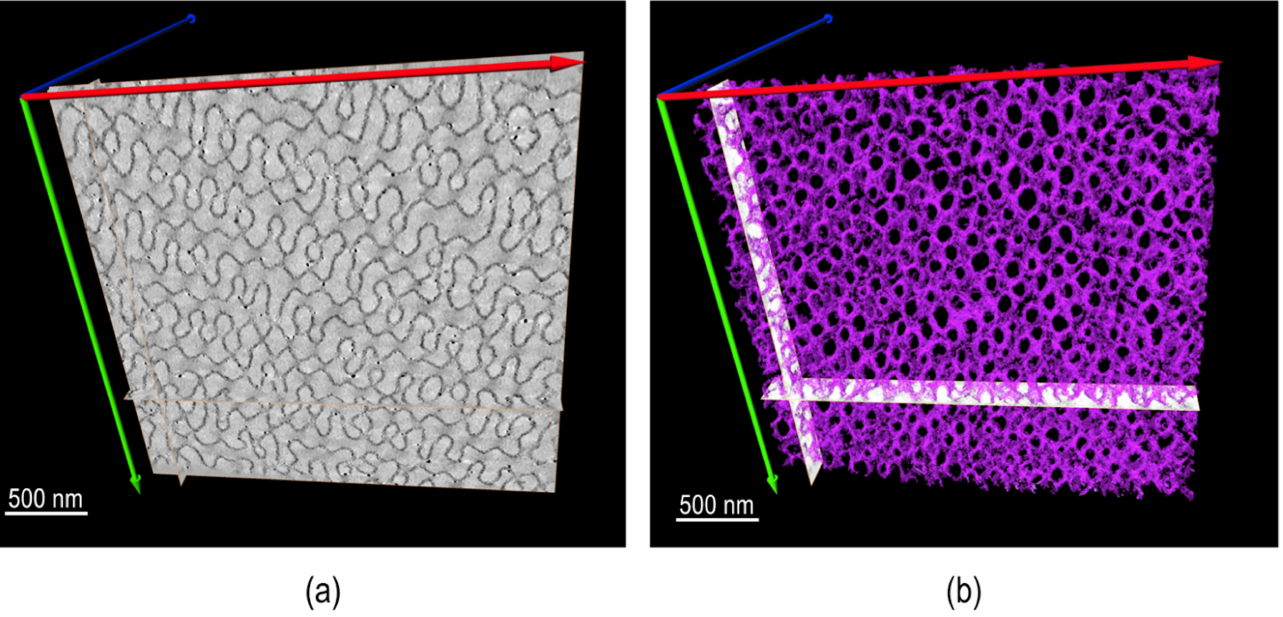
Figure 12. PS-b-PAA porous particles: ( a ) TEM image and ( b ) TEM tomography reconstruction of a 100nm slice. Repro- ducedfrom [113], under the terms of the Creative Commons CC BY license [18]. No changes have been